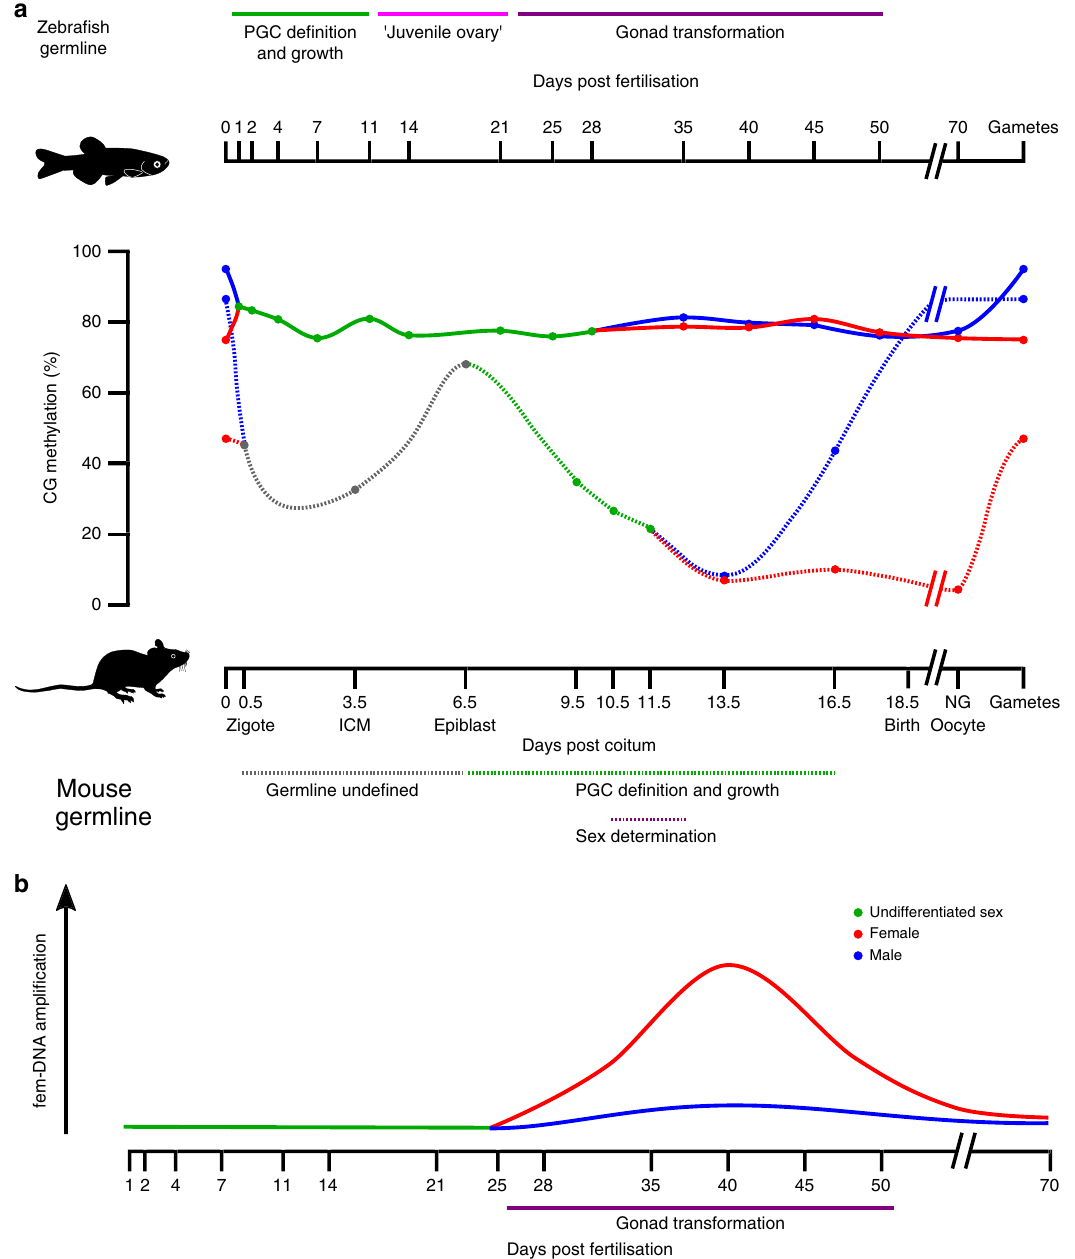
Fig. 5 Global DNA methylation and fem-rDNA dynamics in the zebra fi sh germline. a CG methylation in the mouse and zebra fi sh germline. In stark contrast to mice, the zebra fi sh germline does not undergo extensive erasure of DNA methylation and germline DNA from females (red), males (blue) and fi sh of undifferentiated sex (green) are similar. Note, data for mouse were taken from the meta-analysis provided by Lee, Hore and Reik 41 . b Striking ampli fi cation of fem-rDNA occurs in germline cells during the critical period of gonad transformation in females. Beginning around 28 dpf perinucleolar oocytes amplify in at least 2 orders of magnitude oocyte-speci fi c 45S rDNA. ICM, inner cell mass; non-growing (NG)